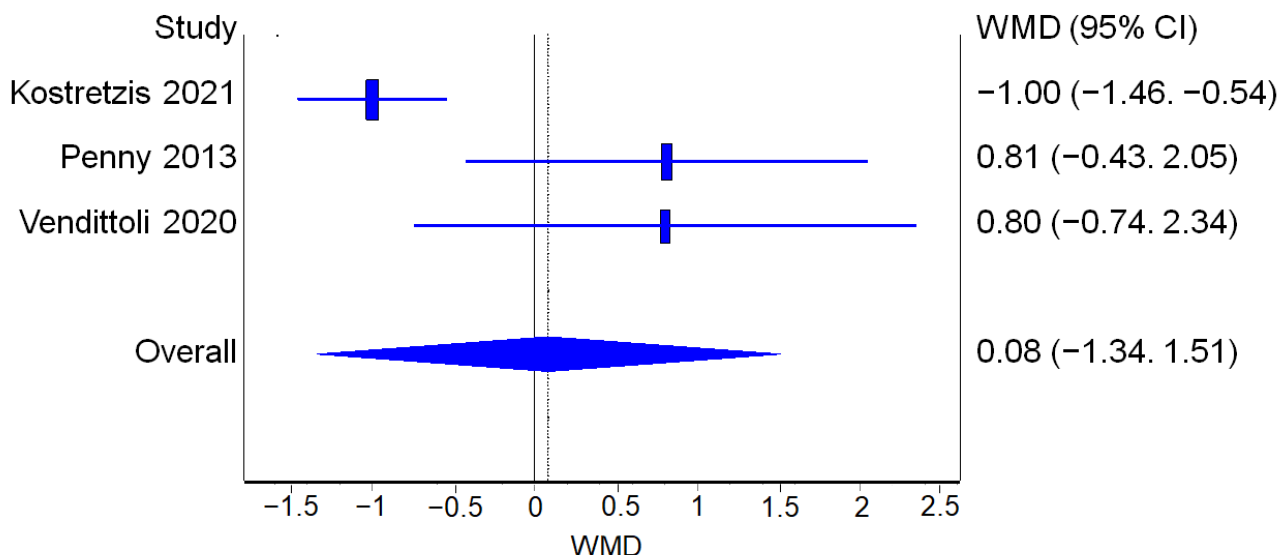
Figure 9. UCLA: Forest plot of the individual studies and pooled mean difference for UCLA improvement, including a 95% confidence interval. The size of the squares shows the weight of the study [17–20,25,28–31].